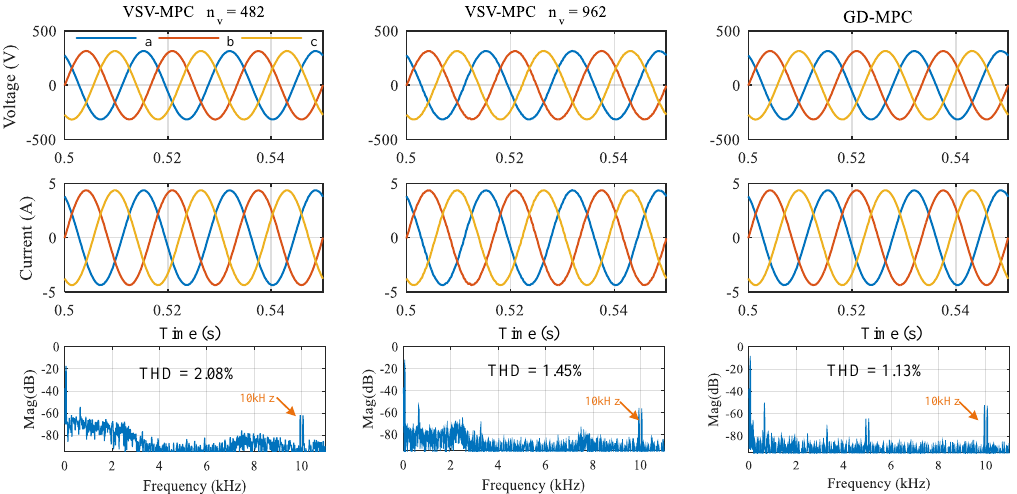
Figure 10. Comparison on the proposed GD-MPC method and the VSV-MPC method.